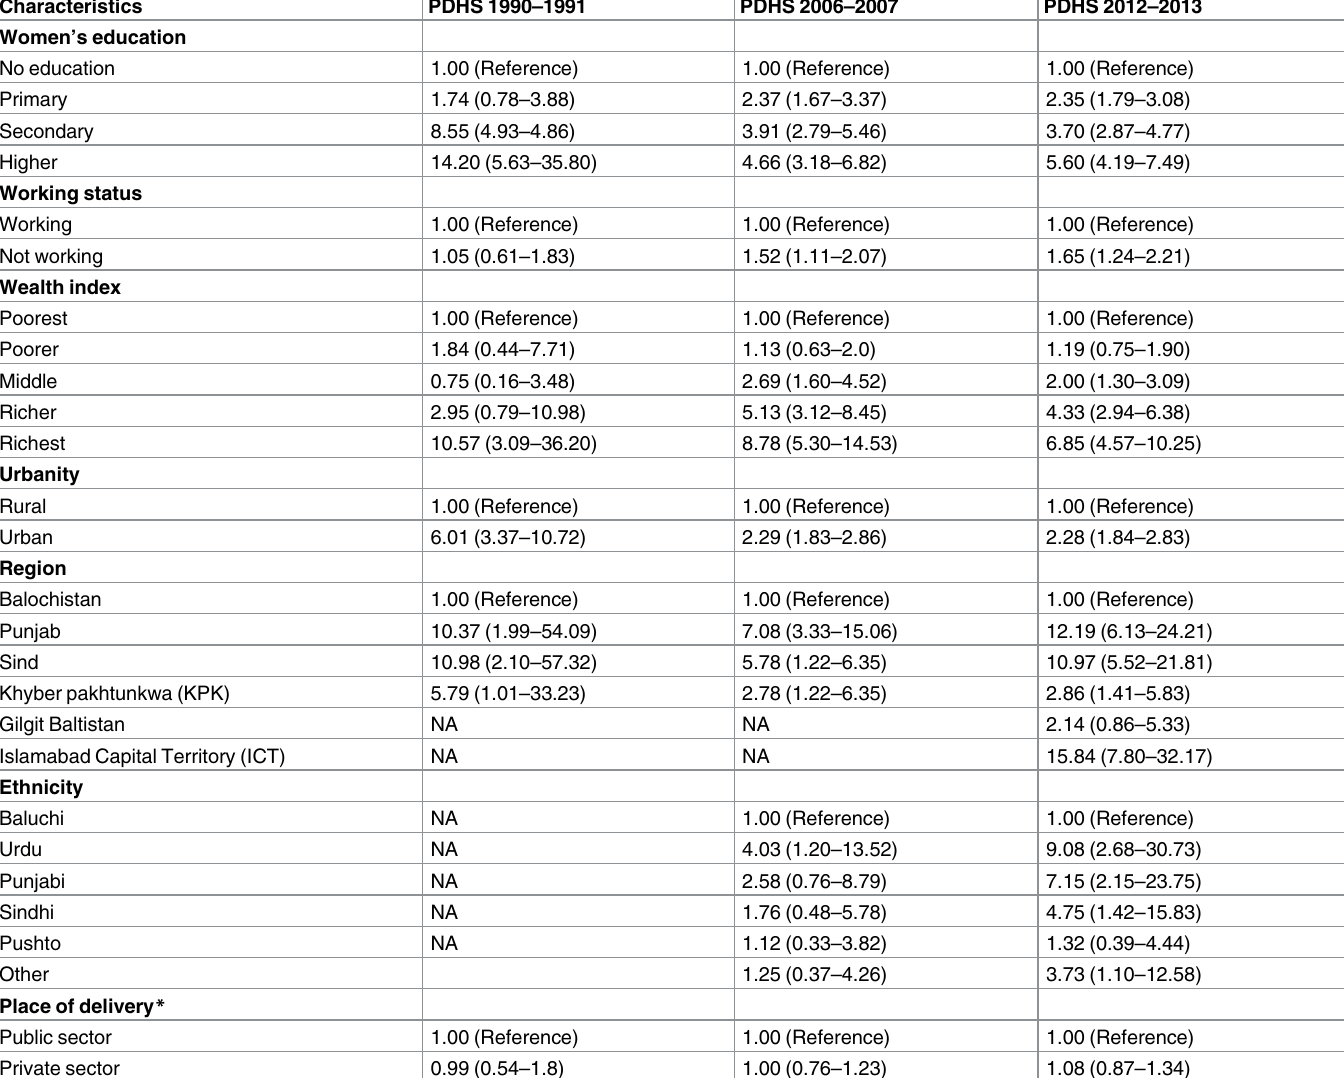
Table 4. Maternal age- and parity-adjusted odd ratios of cesareansection from the Pakistan Demographic and Health Surveys(PDHS) in 1990– 1991, 2006–2007, and 2012–2013.